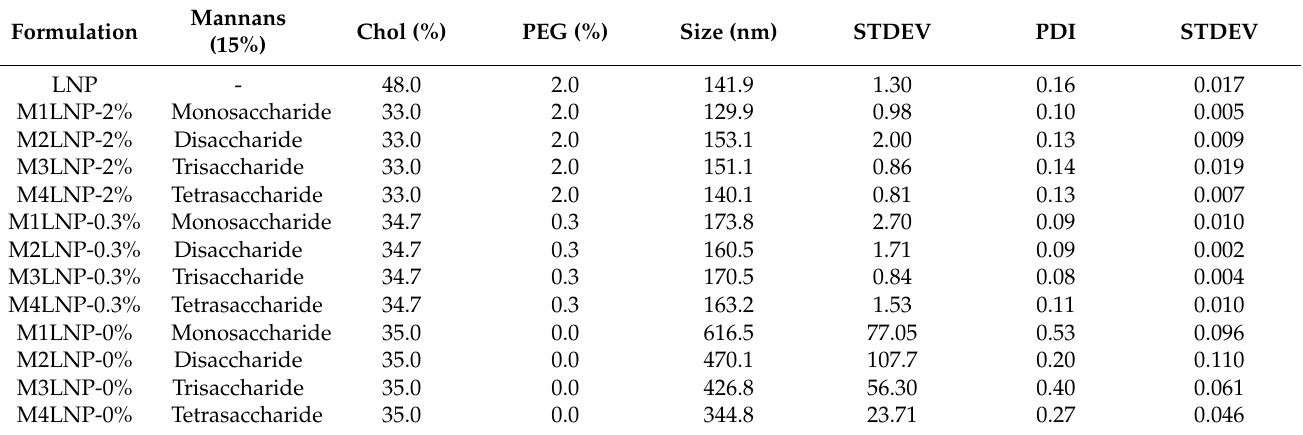
Table 1. Characteristics of the different formulations prepared with the different mannan length and PEG content. DLinDMA and DSPC concentrations were kept constant in all the formulations at 40% and 10% molar concentration, respectively. Formulation